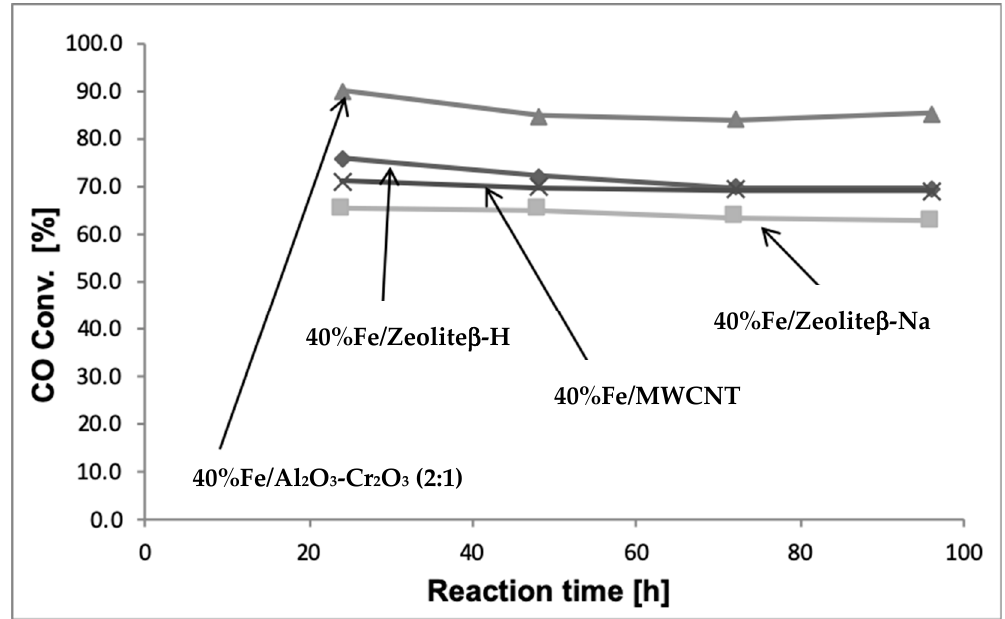
Figure 1. The carbon monoxide conversion values of iron catalysts supported on various supports obtained in the Fischer-Tropsch (F-T) process performed in a reaction mixture at 280 °C (50% H 2 :50% CO) at 30 atmospheres using a 2 g sample in each test.